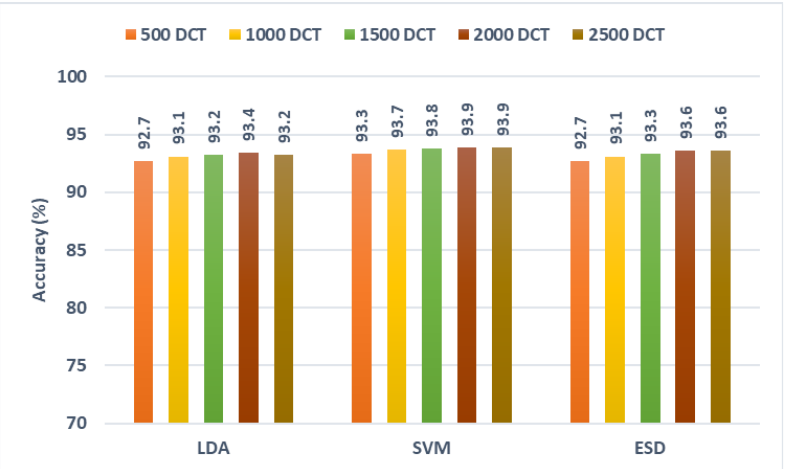
Figure 10. Diagnostic accuracy of the three classifiers trained with integrated features of the third fusion stage (fusing of the second fusion stage features of the three CNNs using DCT) versus the number of DCT features.